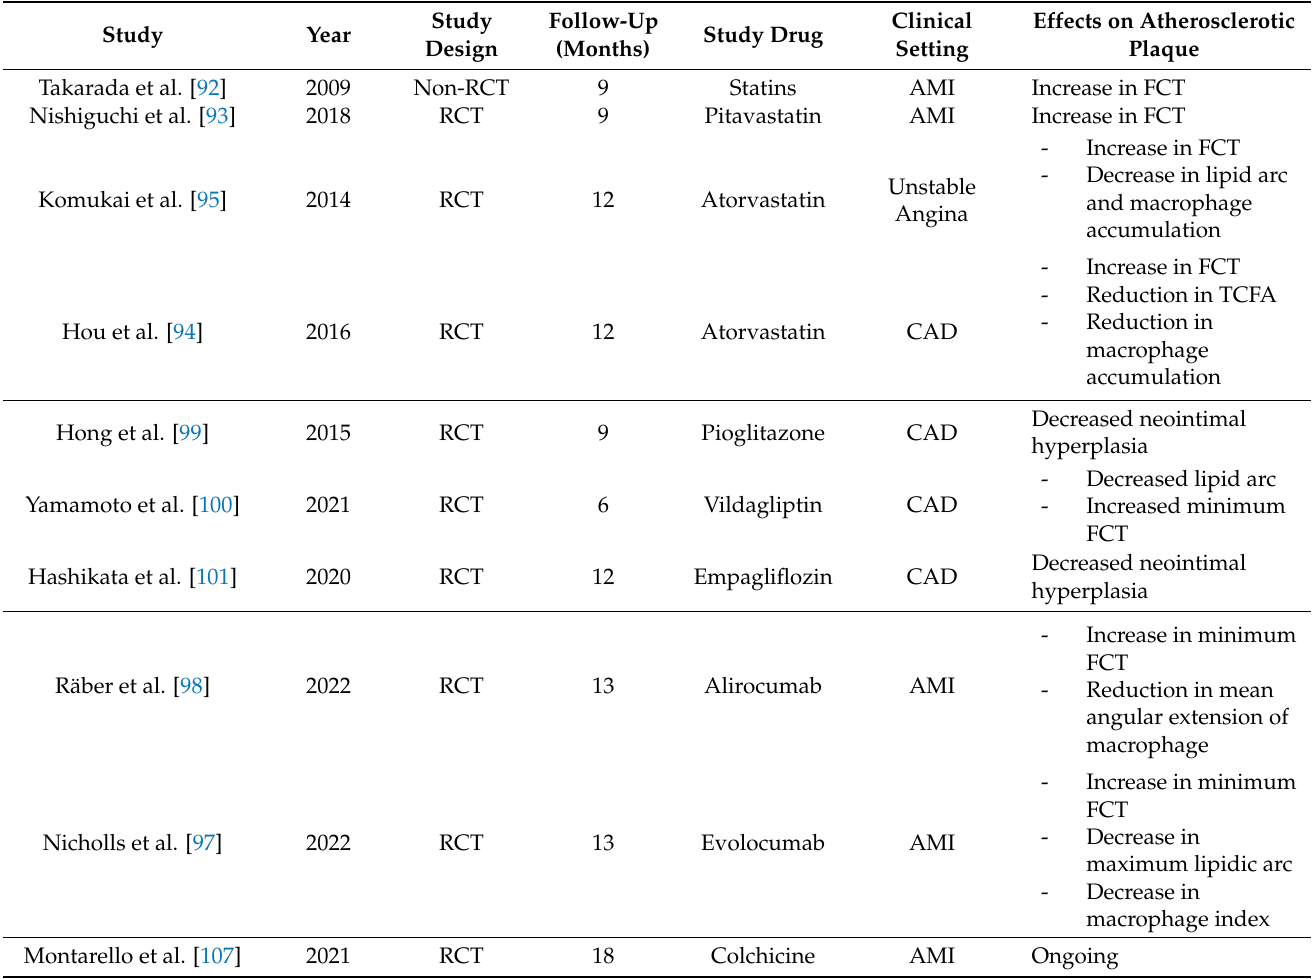
Table 2. Summary of the available evidence on OCT-based plaque modification of different pharma- cological